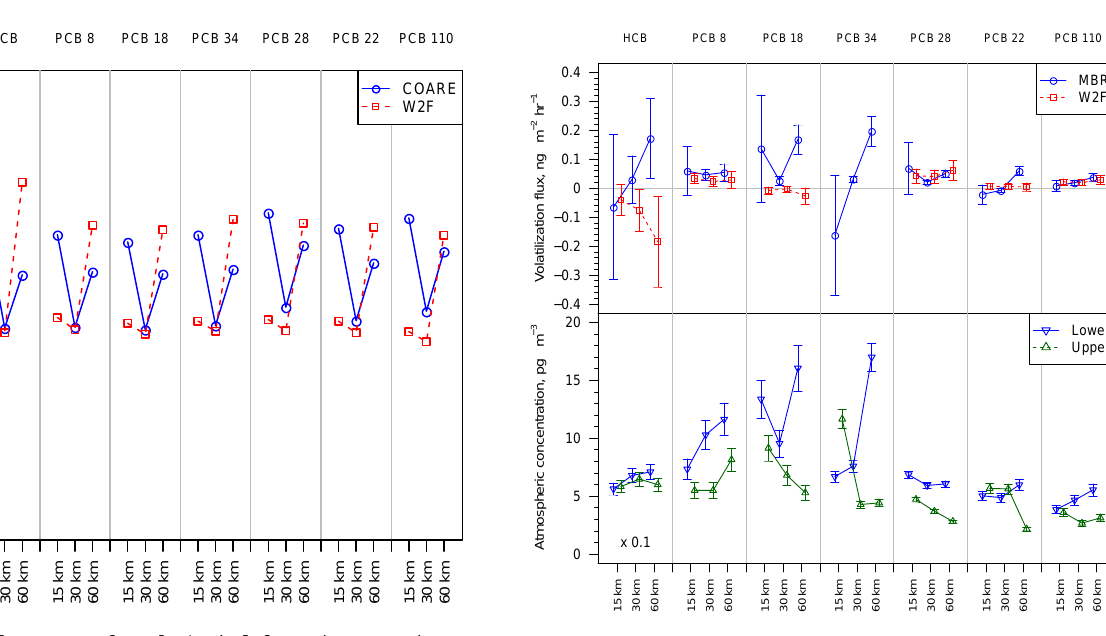
Fig. 3. In five of seven cases in which the MBR flux